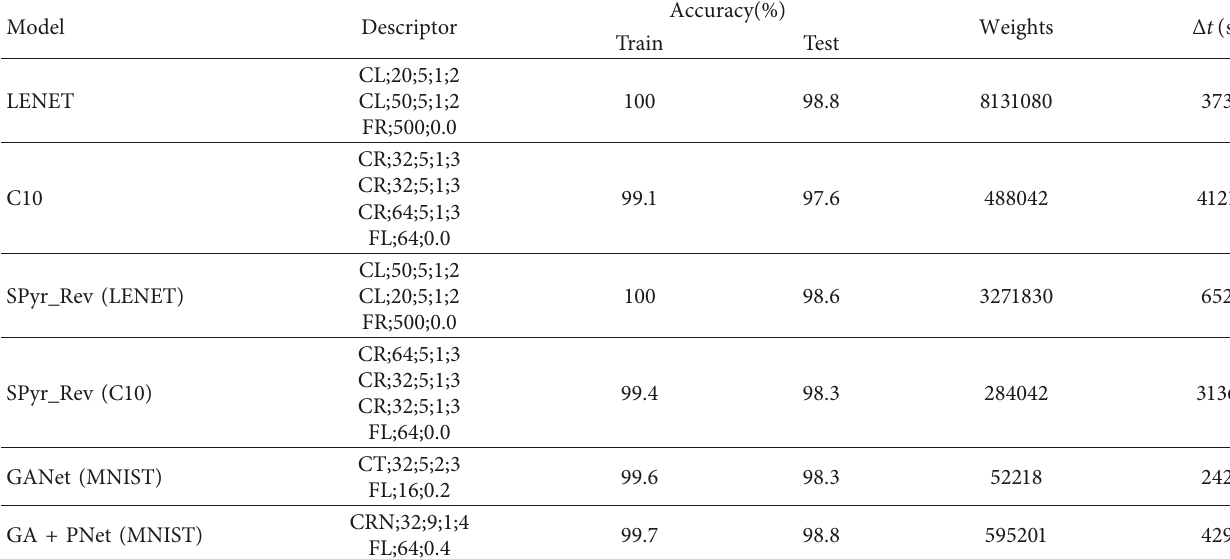
Table 7: Optimized and reference models